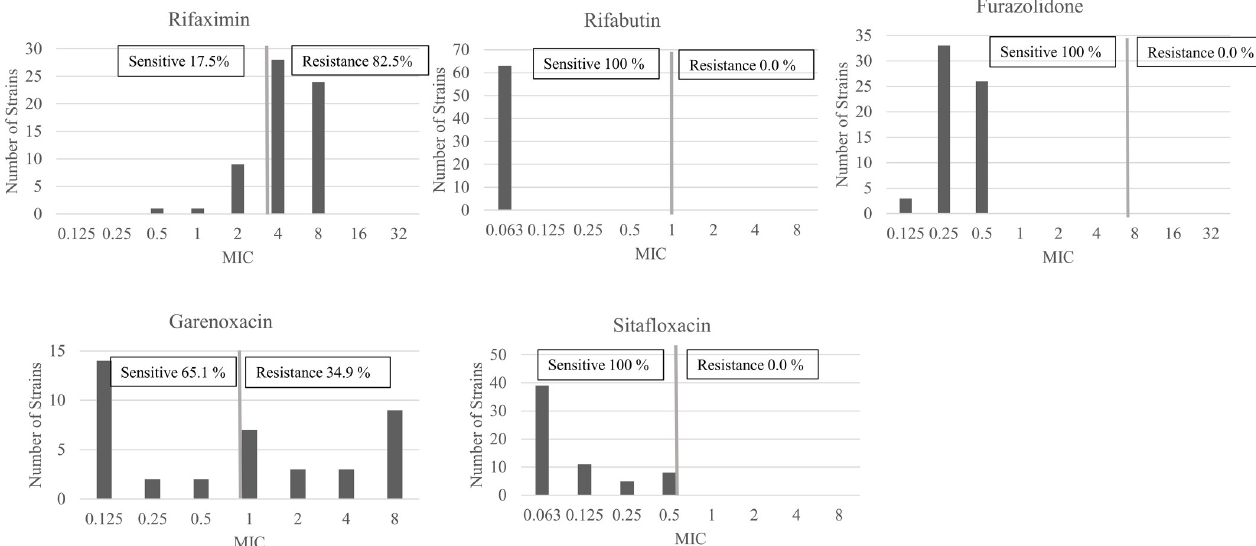
Fig 1. The distribution of alternative antibiotic susceptibility test result in Dominican Republic. The H . pylori resistance rate of rifaximin and garenoxacin were high in Dominican Republic. In contrast, all H . pylori isolate from Dominican Republic were sensitive towards rifabutin, furazolidone, and sitafloxacin.